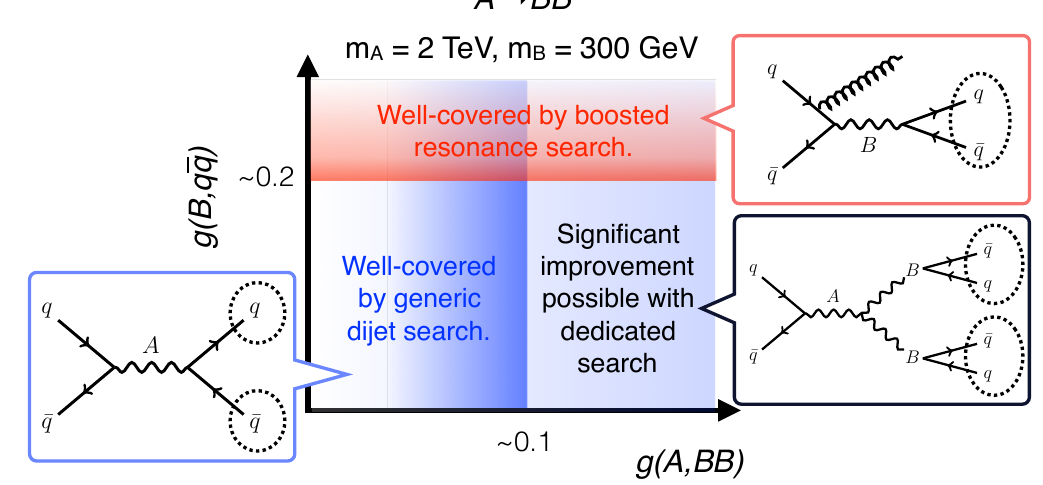
Figure 1 . An illustration of the complementarity of the search for A (inclusive dijet resonance search) and the search for B (boosted resonance search). Dotted circles indicate hadronic activity that will likely be mostly captured by one (potentially large-radius) jet. When m A = 2 TeV and m B = 300 GeV, the inclusive dijet search likely has reduced sensitivity to A ! BB because the B decay products are not well-contained inside a single small-radius jet. Therefore, when g ( A; BB ) & g ( A; q (cid:22) q ) (cid:24) 0 : 1, gains are possible for a dedicated search.